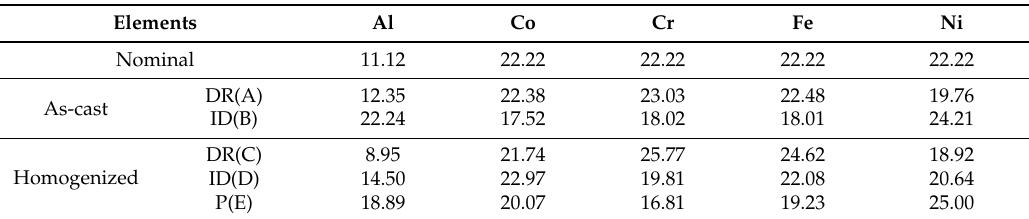
Figure 2. Initial microstructure of the ( a ) as-cast and ( b ) homogenized Al 0.5 CoCrFeNi HEAs. A, B, C, D and E correspond to different phases (A — DR, B — ID, C — DR, D — ID, E — P). Table 1. The nominal composition and actual chemical compositions (in atom %) of different phases of the Al 0.5 CoCrFeNi HEAs.